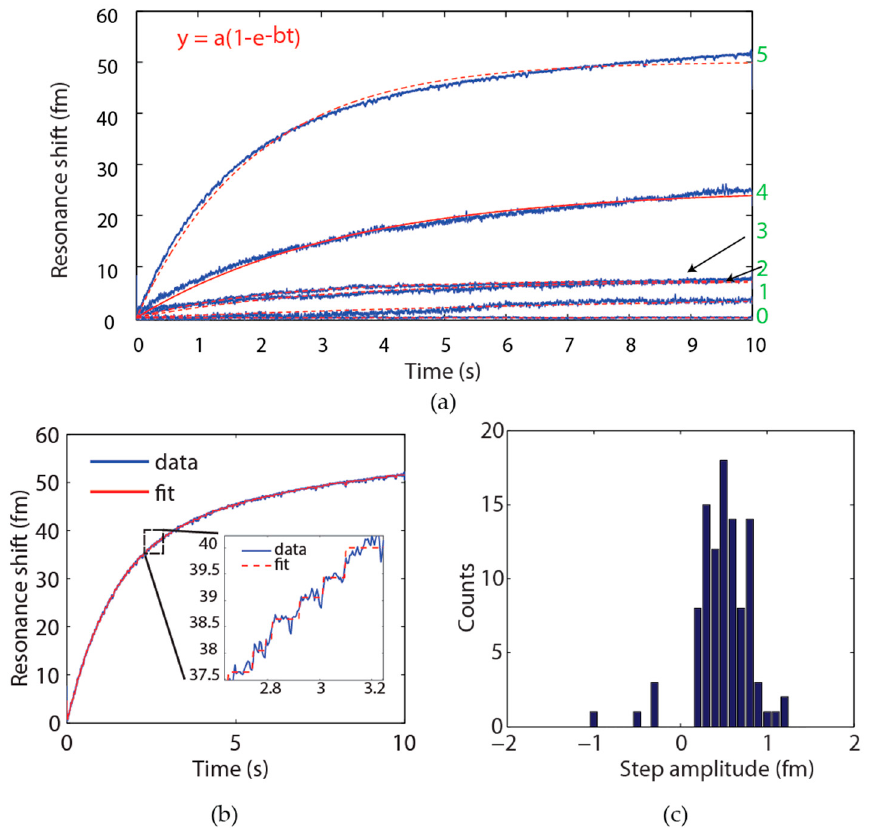
Figure 9. Exosome detection data obtained using FLOWER ( a ) Exosome binding curves. Mice were implanted with human Burkitt’s lymphoma tumor cells, and each week blood serum samples were taken and later analyzed all together using FLOWER. The curves shown here are from a single mouse. For each week we see an increase in the response from the sensor corresponding to increasing exosome levels. Weeks are indicated in green. No significant signal was obtained from Week 0. The data traces are fit with a simple exponential (dashed red line) corresponding to first-order kinetics. ( b ) Zoom-in of Week 5 and corresponding step-fit (red) and ( c ) histogram of step heights. Individual steps corresponding to the binding of individual exosomes may be seen. Negative step amplitudes represent unbinding events. Reprinted (adapted) with permission from [16]. Copyright 2015 American Chemical Society.